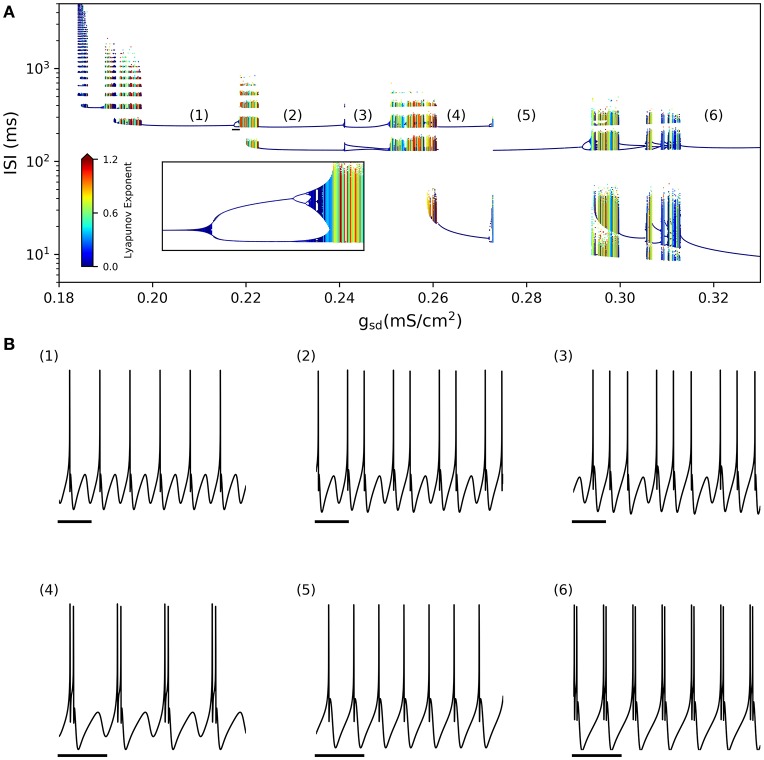
(A) ISI bifurcation of the model as the gsd parameter is changed and gh is fixed to 0.2 mS/cm2. Numbers denote different firing modes between which chaotic regions are found. Inset shows a detail of the ISI-doubling events to the right of region (1), from gsd = 0.217–0.219. (small black bar in the large plot) (B) Sample voltage trajectories showing the firing modes. (1), (2), and (3) correspond to different skipping patterns; (4) is bursting with skipping; (5) is regular tonic; and (6) is regular bursting. In all traces the scale bar is 250 ms.